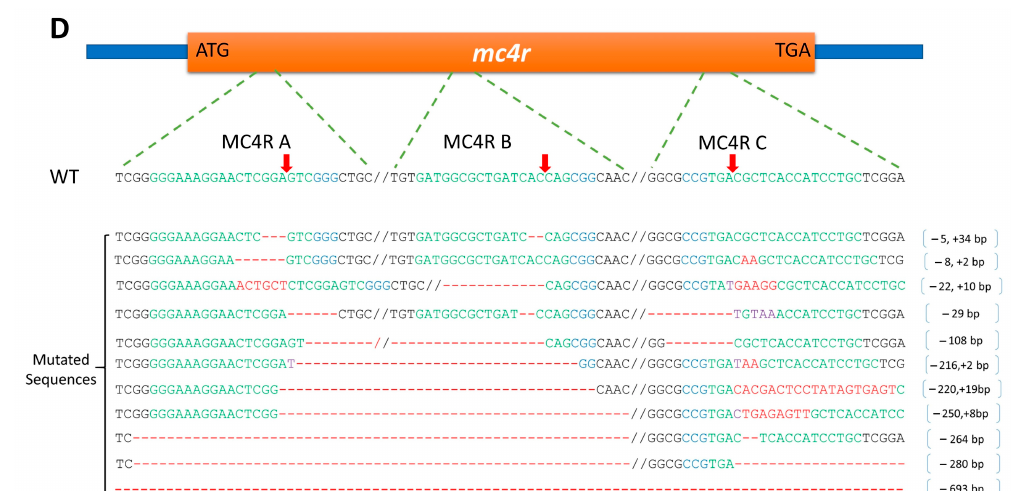
Figure 6. CRISPR-Cas9-induced mutagenesis in the melanocortin-4 receptor ( mc4r ) gene of channel catfish, Ictalurus punctatus , Kansas random strain through microinjection of guide RNAs and Cas9 enzyme. The partial sequence of wild-type channel catfish mc4r gene (WT) is the top sequence in each panel. Sequences in green and blue colors are the target sites of the sgRNAs followed by the protospacer-adjacent motif (PAM) sequence, respectively. Red arrows indicate the expected sites of cleavage by Cas9. Dashes indicate the deletion of nucleotides along the mc4r gene. The plus (+) and minus ( − ) signs indicate insertions and deletions, respectively. ( A ) MC4RA treatment, ( B ) MC4RB treatment, ( C ) MC4RC treatment, and ( D ) MC4RMIX treatment.